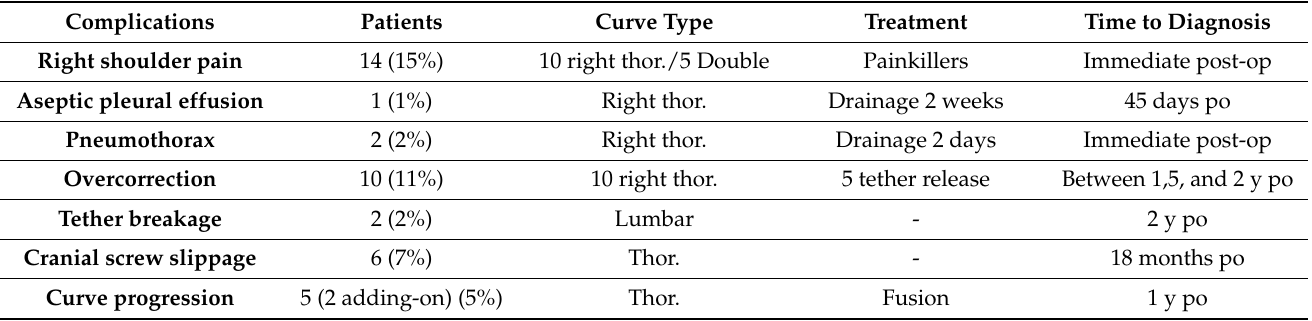
Table 3. Summary of the complication and revision rates. (thor.: thoracic curve, po: post-operative).